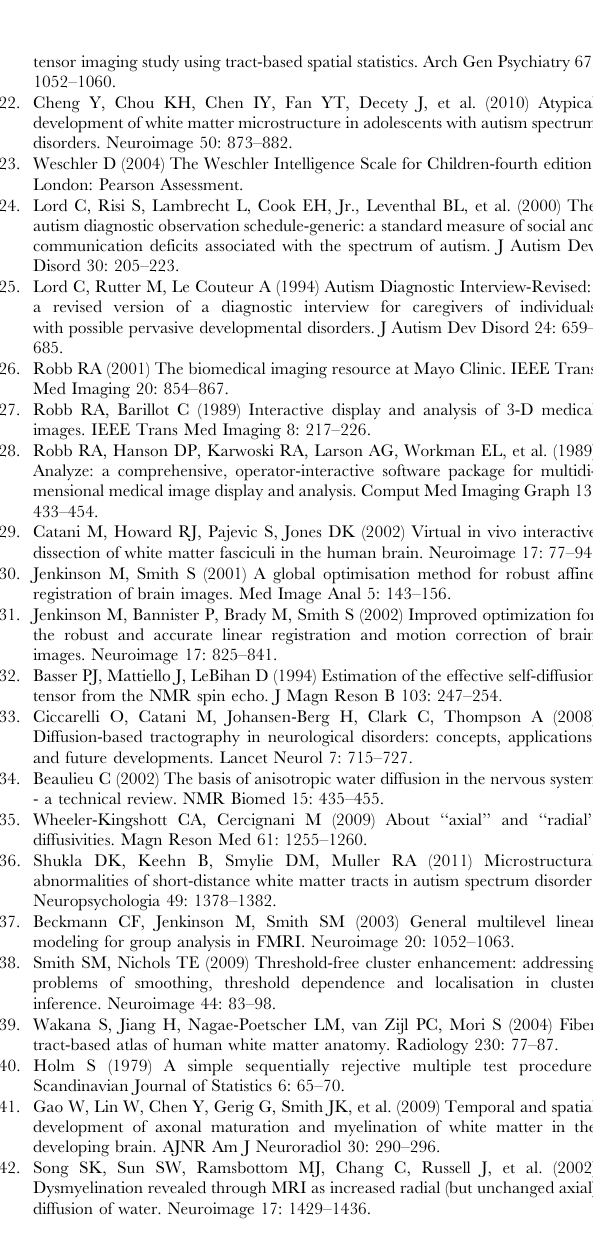
Table S1 Tract-specific diffusivity values for autism spectrum disorder and control children. ASD= autism spectrum disorders; HC = healthy control; Rt= right; Lt= left; CCMj = forceps major, corpus callosum; CCMn= forceps minor, corpus callosum; CR =superior corona radiata; UF= uncinate fasciculus; IFO- F = inferior-fronto-occipital fasciculus; SLF = superior longitudinal fasciculus; ILF= inferior longitudinal fasciculus; diffusivity units = mm2/s 6 10 2 3. *significant following multiple comparison correction. Table S2 Tract-specific diffusivity values for autism spectrum disorder and control adolescents. ASD= autism spectrum disor- ders; HC =healthy control; Rt = right; Lt=left; CCMj = forceps major, corpus callosum; CCMn = forceps minor, corpus